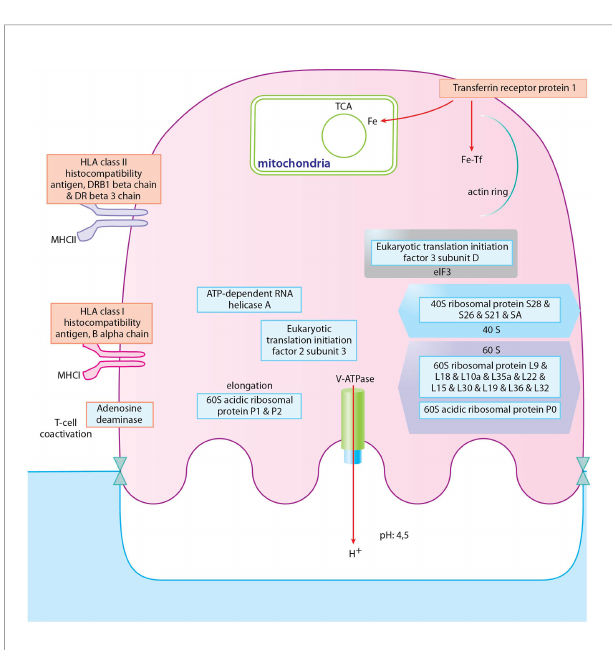
FIGURE 8 | Depiction of proteins signi fi cantly expressed in osteoclasts of RA donors. Proteins with blue frame represent proteins of ATP biosynthetic processes pathway, proteins with red frame represent proteins of regulation of T cell mediated cytotoxicity pathway. Blue fi lling shows downregulation of proteins in RA osteoclast samples compared to healthy ones, red fi lling shows upregulation of proteins.